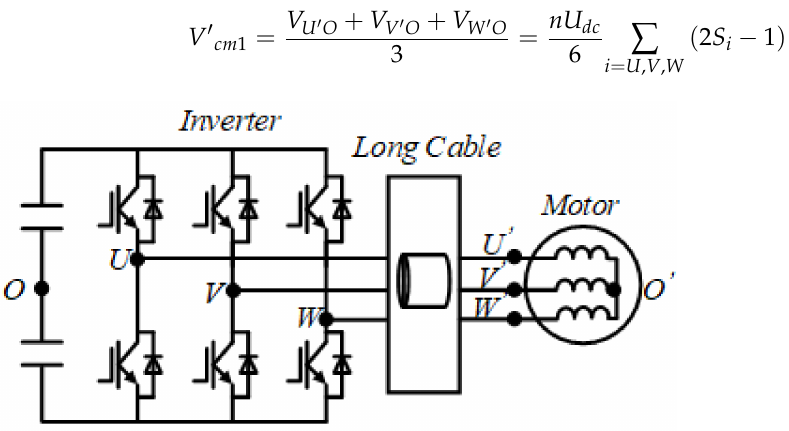
Figure 16. Simplified drive system used to analyze the CM noise.